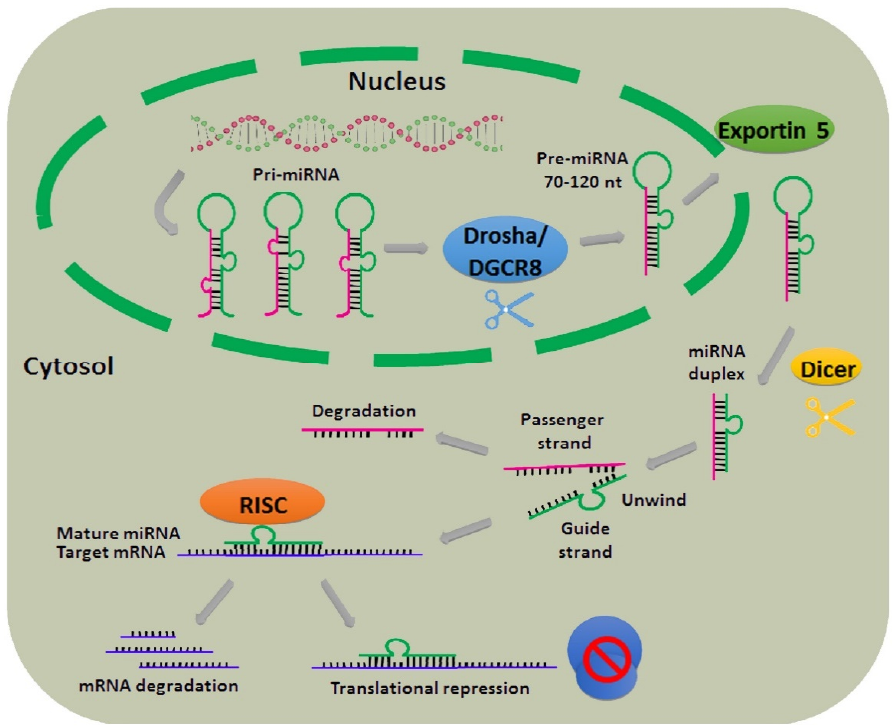
Figure 1. Biogenesis of miRNAs and their roles in translational repression.